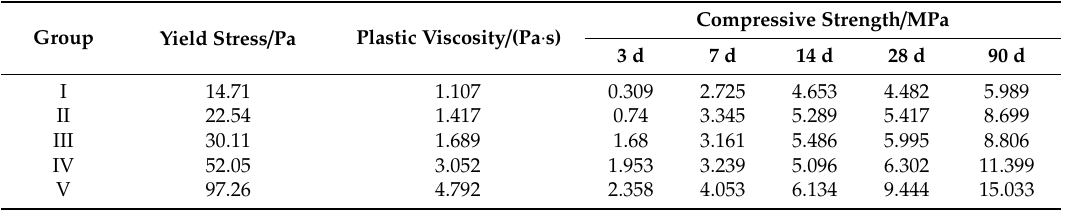
Table 5. Experimental data.